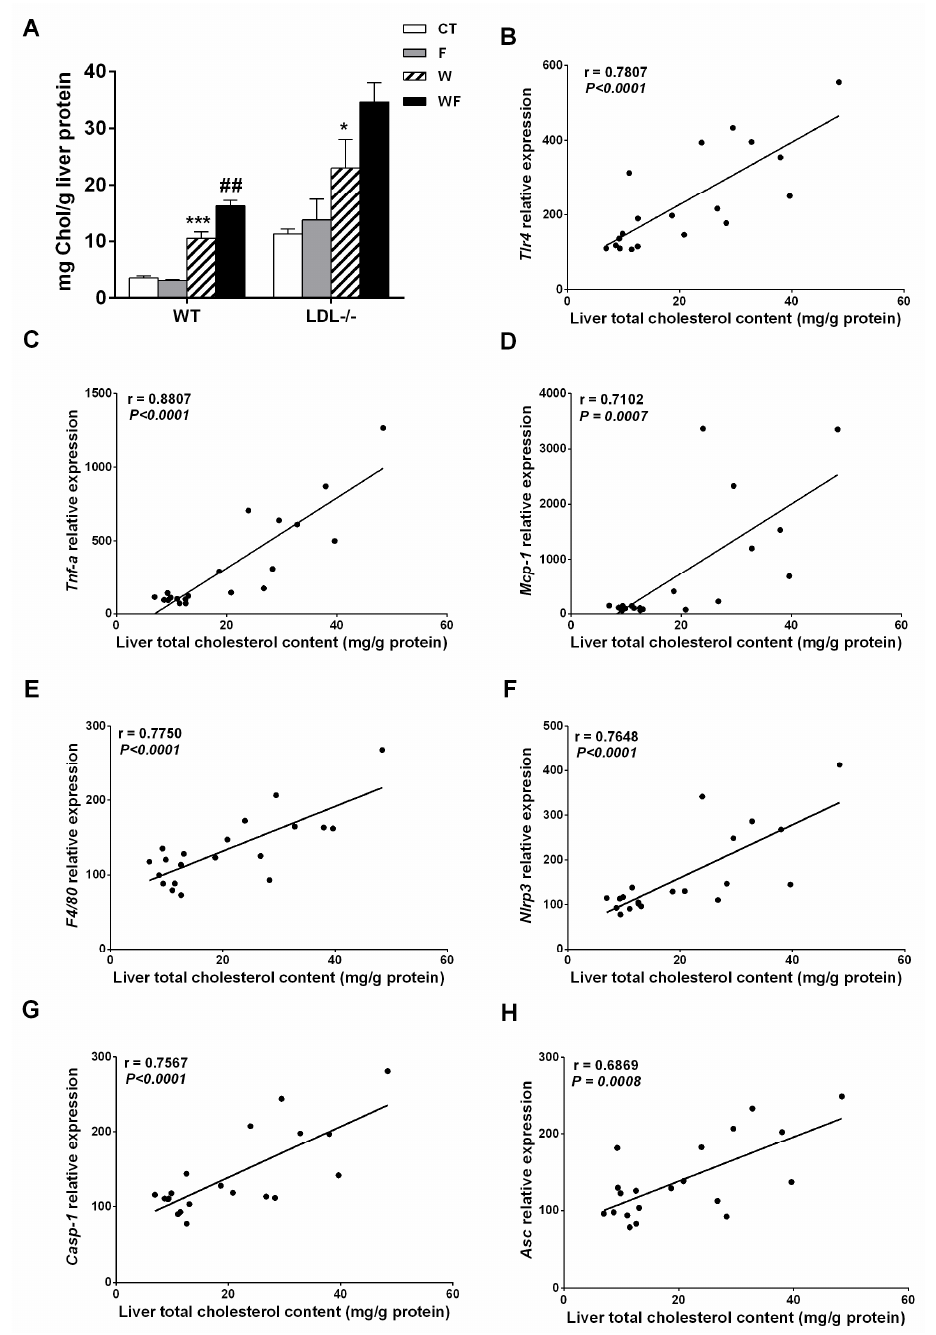
Figure 7. ( A ) Liver cholesterol levels from wild ‐ type (WT) and LDL ‐ R − / − mice fed standard solid ‐ chow (CT), standard solid ‐ chow plus a 15% fructose solution ad libitum (F), Western solid ‐ chow (W), and Western solid ‐ chow plus a 15% fructose solution ad libitum (WF), expressed as mean ± SEM of 9–10 animals; Data were obtained from [17,18]. Correlation between liver cholesterol content and mRNA expression of pro ‐ inflammatory molecules including: ( B ) toll ‐ like receptor 4 ( tlr4 ); ( C ) tumor necrosis factor ( TNF ‐α ); ( D ) monocyte chemoattractant protein ‐ 1 ( mcp ‐ 1 ); ( E ) f4/80; ( F ) NLR family pyrin domain containing 3 ( nlrp3 ); ( G ) caspase ‐ 1 ( casp1 ) and ( H ) apoptosis ‐ associated speck ‐ like protein containing a caspase ‐ recruitment domain ( asc ). Statistical analysis was performed using two tailed Pearson or Spearman correlation. R indicates correlation coefficient.